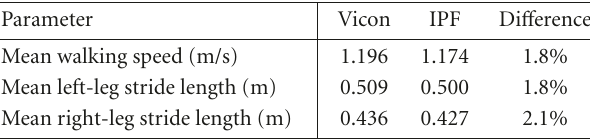
Table 1: Comparison between the IPF and Vicon systems. Data are mean values for two subjects.